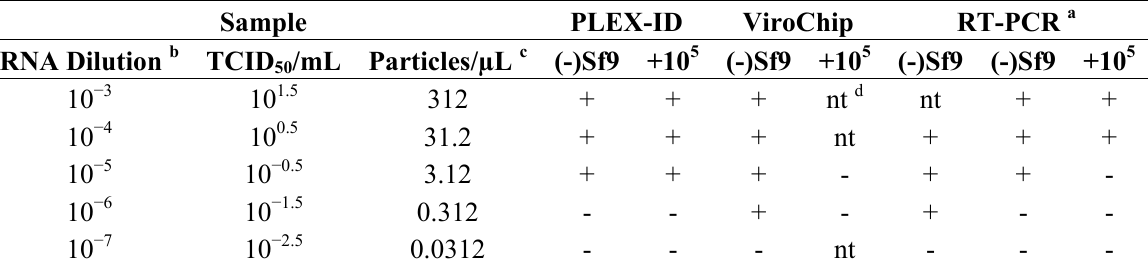
Table 1. Limit of detection using XMRV RNA